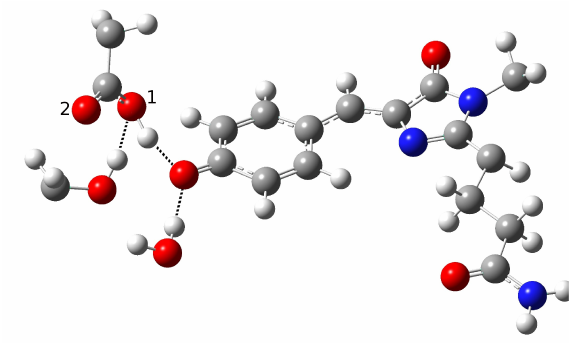
Figure 7. Anionic form resulting from the optimization of psamFP488 starting from the second HB network.